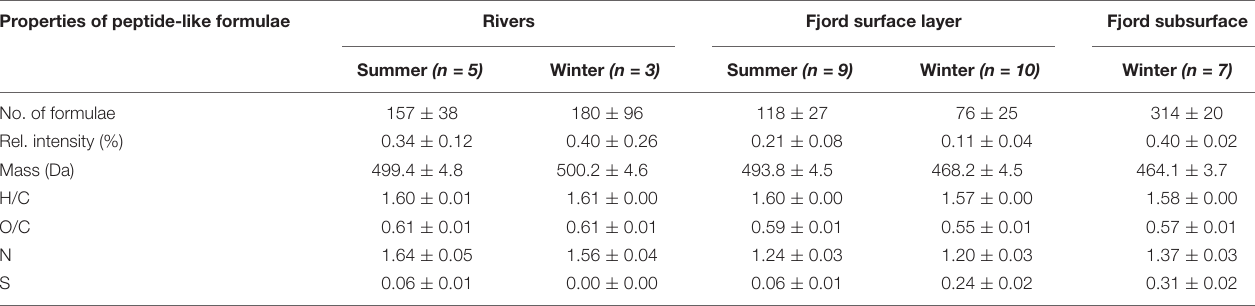
TABLE 3 | Comparison of properties of peptide-like formulae detected in FT-ICR MS spectra from river, fjord surface and fjord subsurface water samples in Baker-Martinez Fjord. Properties of peptide-like formulae